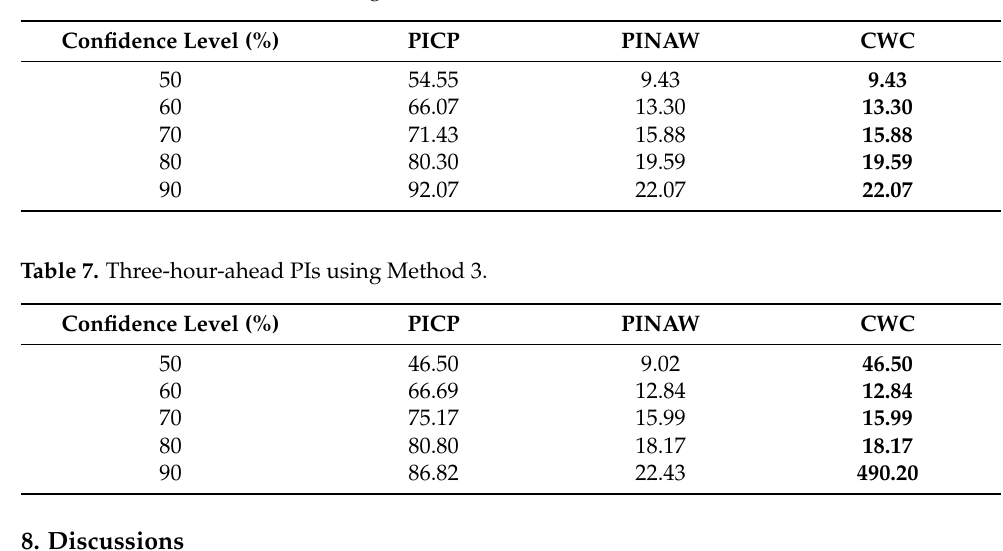
Table 6. Three-hour-ahead PIs using Method 2.